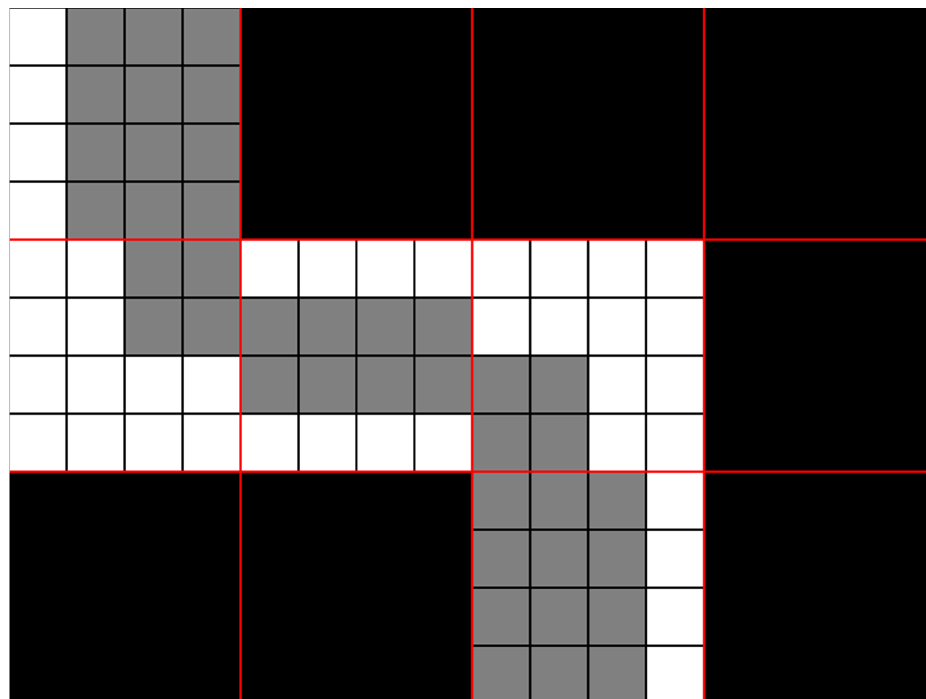
Figure 20. Max Group: A/S = 1.28 with 1 model.